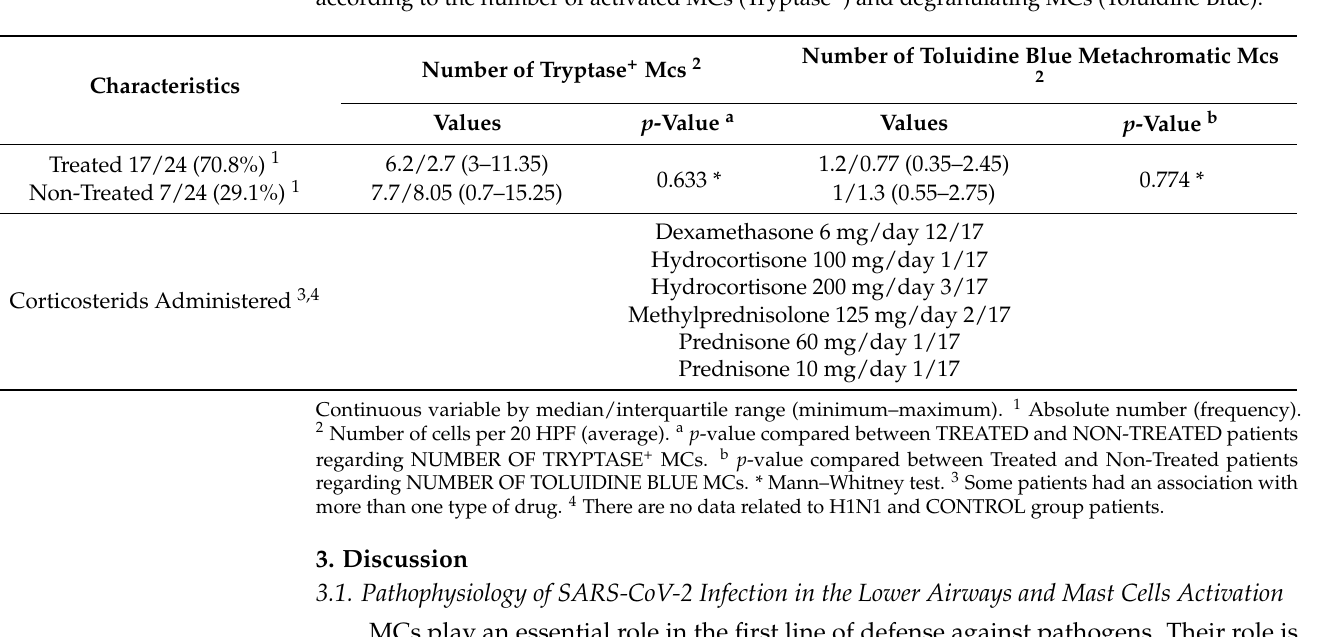
Table 2. Comparison between COVID-19 patients treated and non-treated with corticosteroids, according to the number of activated MCs (Tryptase + ) and degranulating MCs (Toluidine